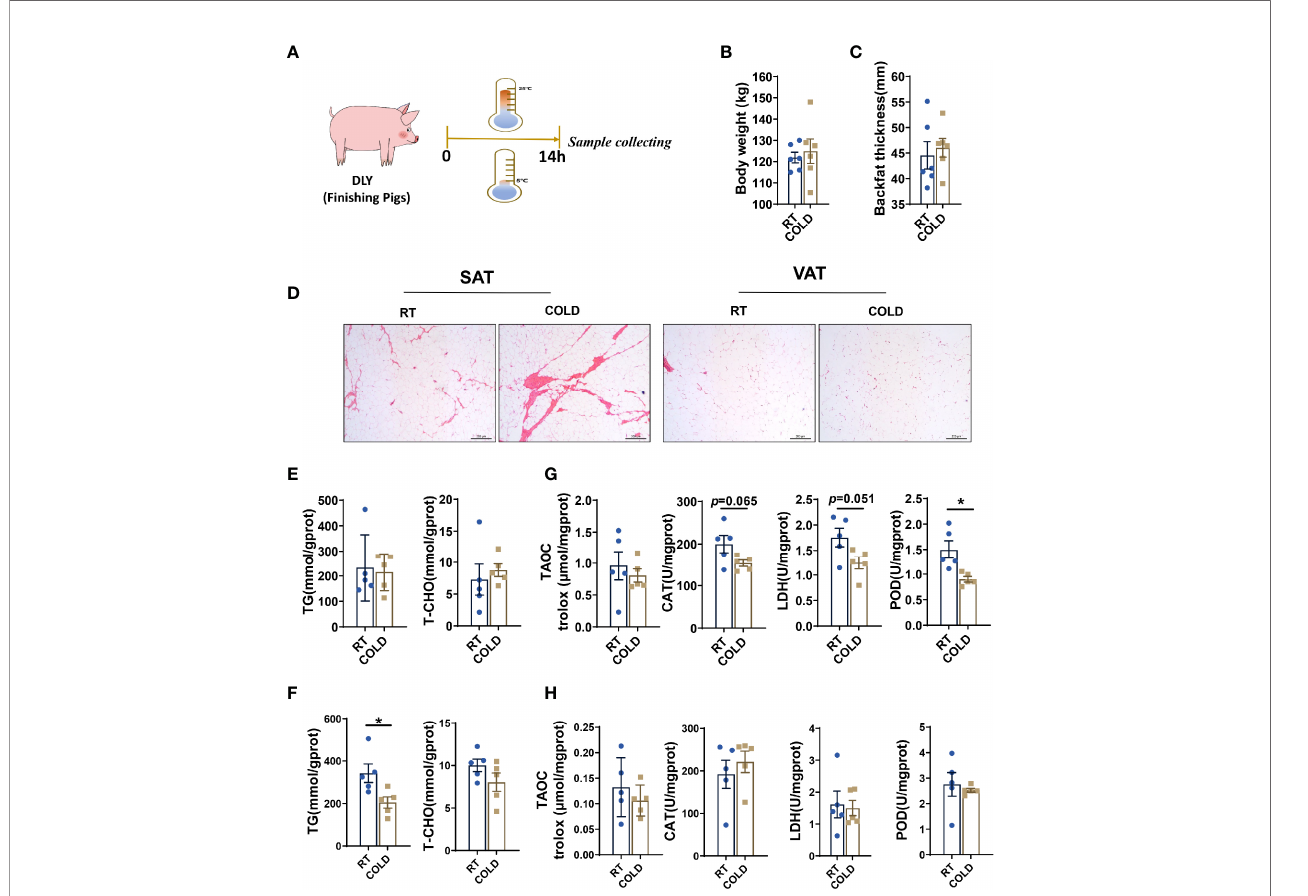
FIGURE 1 | Effect of cold exposure on carcass characteristics, TG and TCHO contents and various enzymes activities. (A) Scheme of the experimental process. (B) Body weight of pigs under RT (room temperature) or COLD (cold exposure) treatment. n=6 for each group. (C) Backfat thickness. (D) H & E staining of SAT and VAT sections from RT and COLD pigs. Scale bars, 300 m m (n=3). (E) TG and TCHO contents in SAT. (F) TG and TCHO contents in VAT. (G) Changes of antioxidant enzymes activities in SAT. (H) Changes of enzymes activities in VAT. Data are presented as mean ± SEM (n = 5). * P < 0.05, two-tailed Student ’ s